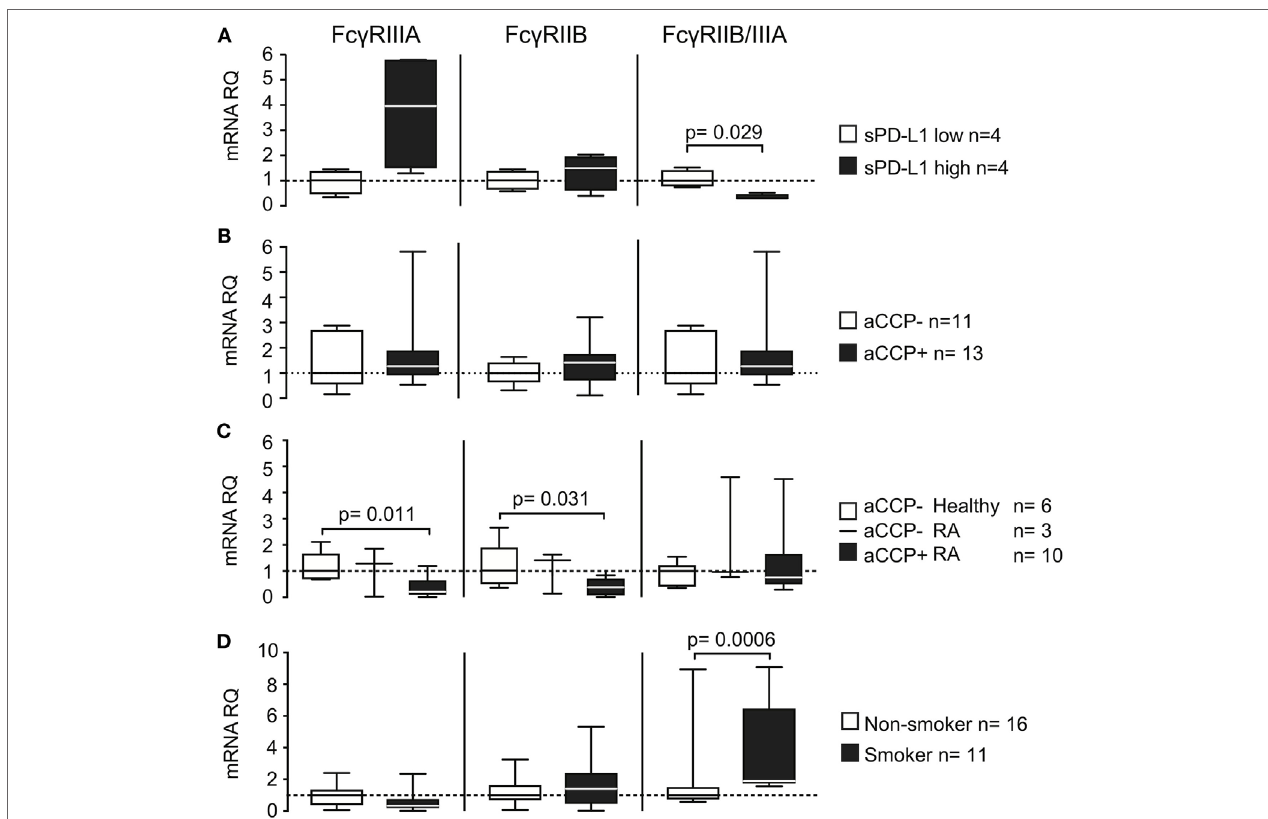
FigUre 4 | Smoking and anti-cyclic citrullinated peptide (aCCP) antibodies regulate production of programed death protein 1 (PD-L1) through Fc γ -receptors. mRNA levels of Fc γ -receptors (Fc γ Rs) IIIA and IIB and their ratio were measured in (A+B) IgG/LPS stimulated peripheral blood mononuclear cells (PBMC) from aCCP antibody negative healthy controls that produced (a) low ( < 10 pg/ml) or high ( > 10 pg/ml) levels of PD-L1 in culture; (B) stimulated with aCCP + and aCCP − IgGs; (c) T cell depleted PBMC from RA patients and healthy subjects with different aCCP status; (D) T cell depleted PBMC from RA patients and healthy subjects with different smoking status. The Mann–Whitney U test was applied. Boxes represent median with interquartile range. Whiskers indicate min and max